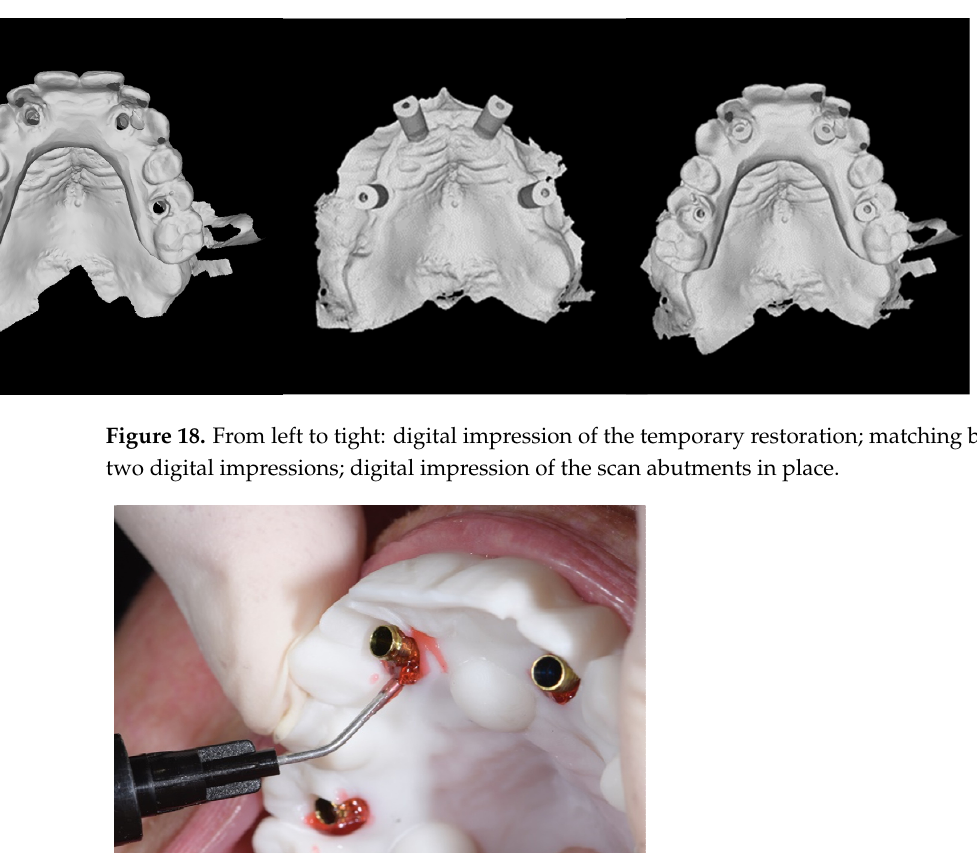
Figure 19. Prototype aesthetic try-in, used for the aesthetic and functional tests.